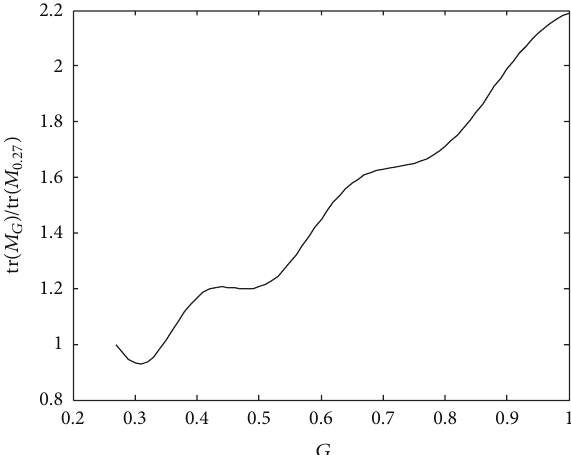
Figure 14: Trace of the measuring matrix: compared with the trace of the critical gain of 0.27 obtained from local optimization, the gain of 0.31 can achieve the minimal trace.